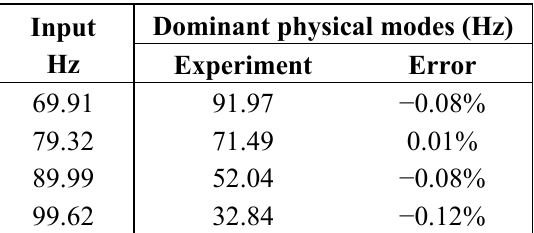
Table 1. Frequency Comparison of the Dominant Non-Physical Mode, Using High Speed Camera to Capture LED signal.